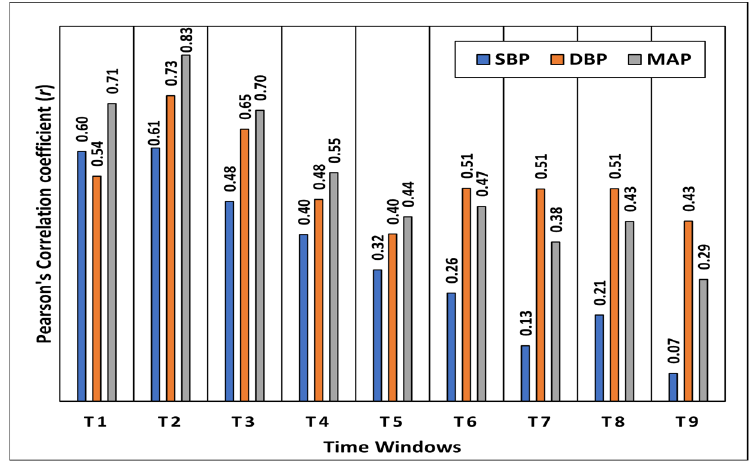
Figure 8. Correlations ( r ) of aPTT to BP at various time windows for TC ‐ 1.